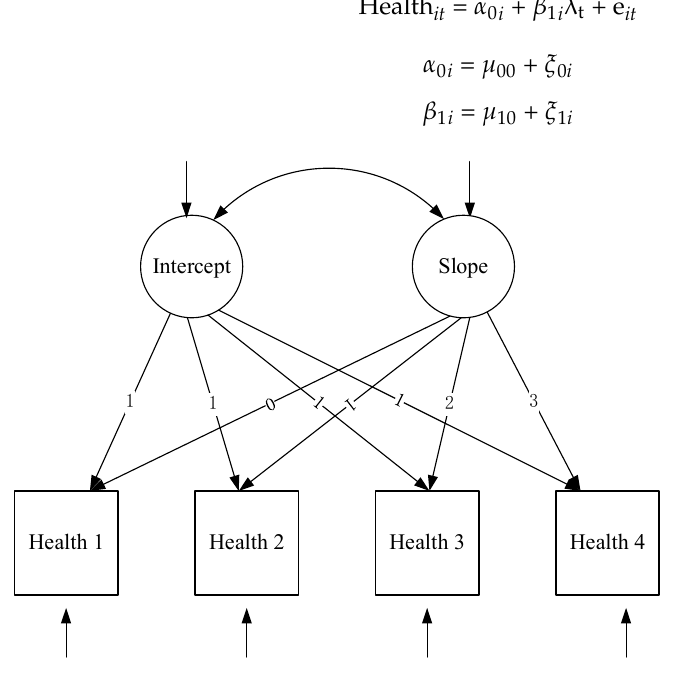
Figure 1. The unconditional linear growth model of the health status of older adults.